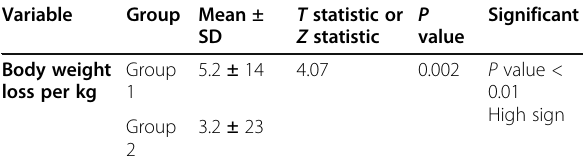
Table 9 The distribution of healing membrane detaching day Variable